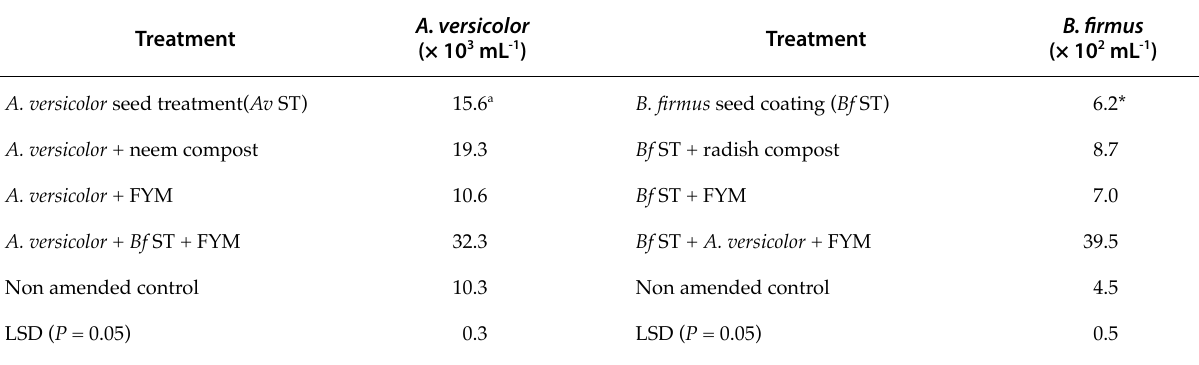
Table 3. Mean populations of Aspergillus versicolor or Bacillus firmus colonizing 45 d old cowpea roots, after application of the biocontrol agents in different soil amendments in 2006.